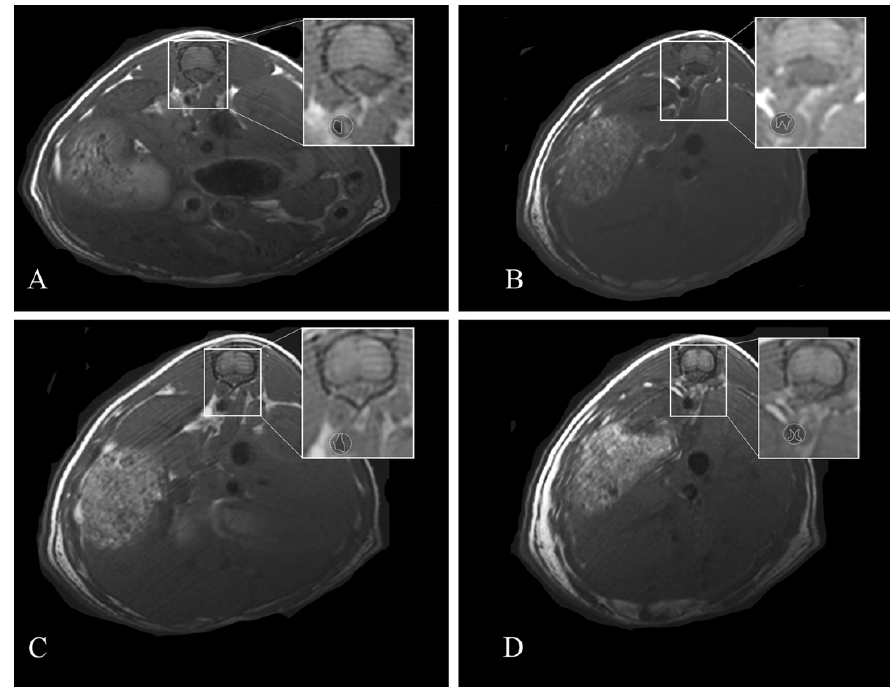
Figure 2. In vivo magnetic resonance cross sectional images (T1 rare) of abdominal aorta. Atherosclerotic plaque protruding into the lumen of the aorta in ApoE − / − HFD+APH at 8 ( A ) and 12 weeks ( B ). Atherosclerotic plaque in the abdominal aorta in ApoE − / − HFD at 8 ( C ) and 12 weeks ( D ).